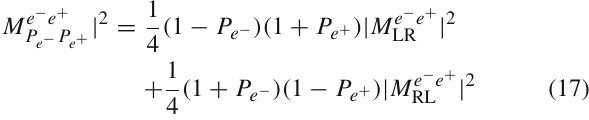
tial electron polarization P e − , for three different benchmark scenarios. In Fig. 6a the initial positron is taken to be unpo- larized, in Fig. 6b we take both initial polarizations to be the equal, and in Fig. 6c we take them to be opposite, as in the mentioned ILC H operation